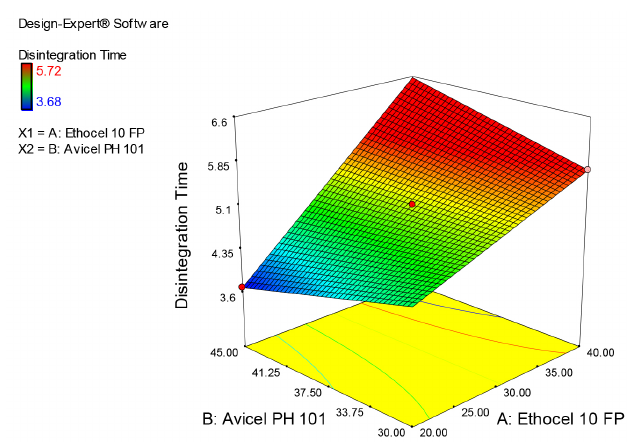
FIGURE 7a - Response surface model (RSM) showing effect of independent variables Ethocel 10FP and Avicel pH 101 on Disintegration time.